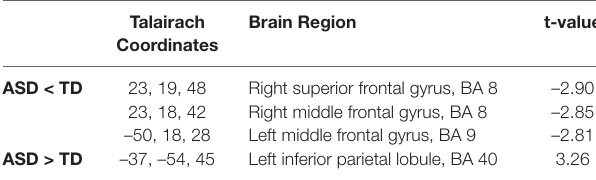
TABLE 2 | Source localization of group differences for Group Map 3 showing differences in activation in brain regions, thresholded at P < 0.01, between the autism spectrum disorder (ASD) group (n = 14) compared to the typically developing (TD) group (n = 14) during free viewing of “Trotro” cartoons. The t-values of the unpaired t-test at the corresponding solution point are